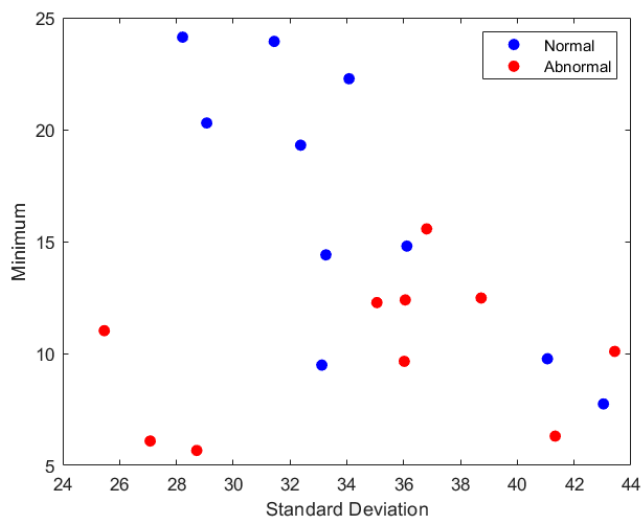
Figure 5. The minimum feature values versus the standard deviation feature values for the first 10 samples of images and their rotated versions.